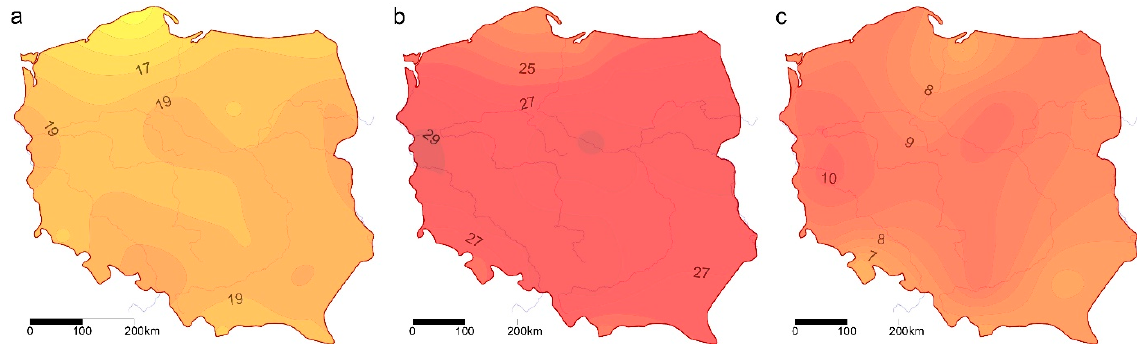
Figure 5. Mean UTCI in June in the years 1966–2019 ( a ), mean UTCI in June 2019 ( b ), and anomalies ( c ).